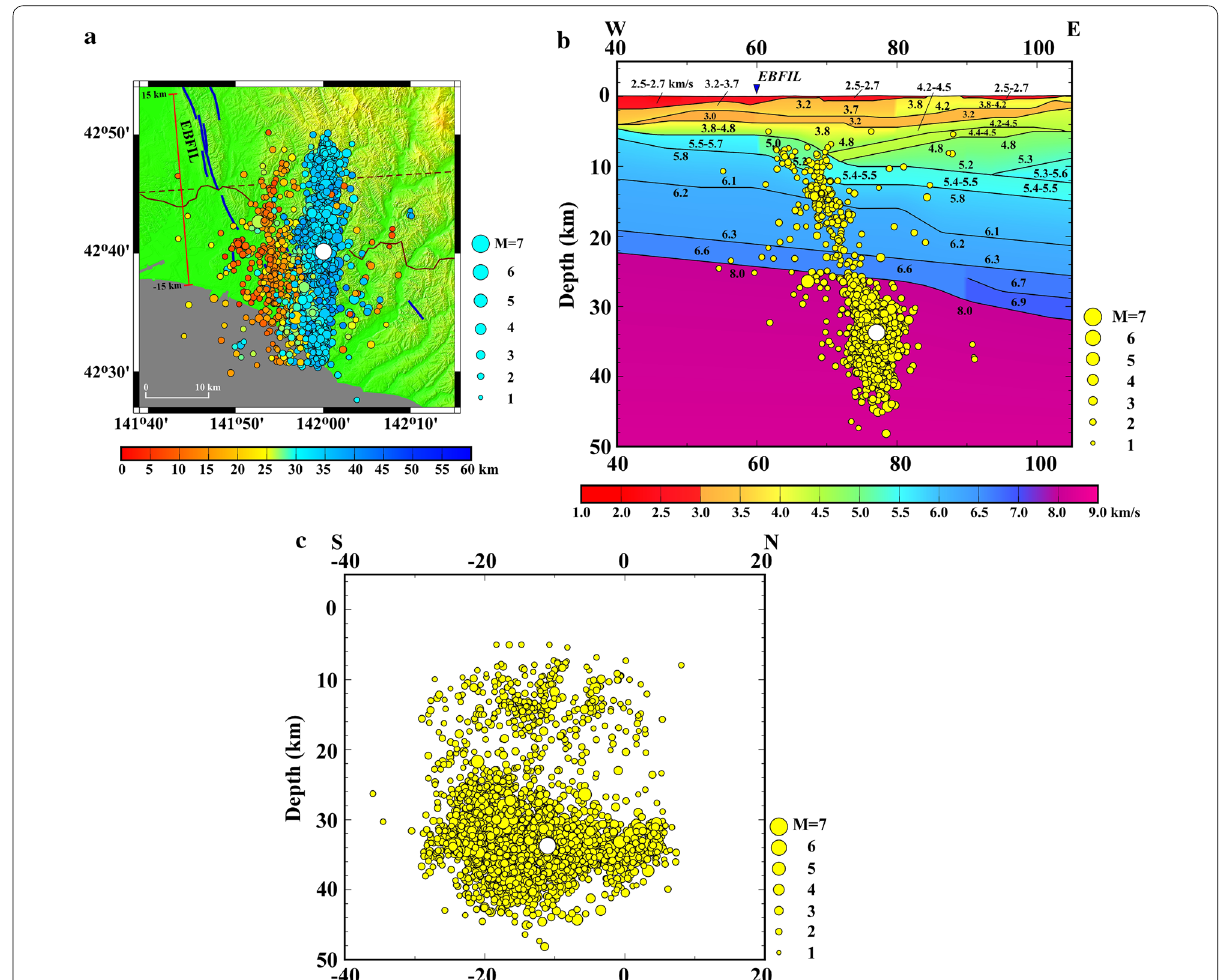
Fig. 10 Hypocenters of the main shock and aftershocks of the 2018 Hokkaido Eastern Iburi Earthquake. a Epicenter map. Brown solid line indicates the 1999–2000 refraction/wide-angle reflection profile of the Hokkaido Transect. All of the relocated aftershocks are shown by yellow circles. A large white circle is a hypocenter of the main shock determined by the present study. Projection line for the cross section in b is shown by a broken line. EBFIL: East Boundary Fault Zone of the Ishikari Lowland. b Cross section. Earthquakes within 15-km distance from the projection line ( a ) are plotted on our velocity model (Fig. 5a). A large white circle is a hypocenter of the main shock determined by the present study. c Cross section perpendicular to that in b . All of the relocated aftershocks are shown by yellow circles. Note clear seismicity gap at a depth of 18–25